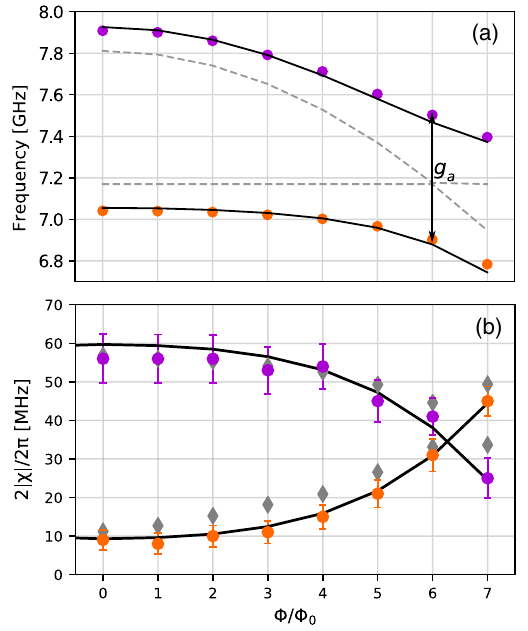
FIG. 9. (a) The lower (orange) and upper (purple) polariton resonant frequencies as function of integer quantum flux. They are fitted (black lines) using the numerical model discussed in Appendix B. The gray dashed lines correspond to the bare cavity and bare ancilla frequencies. An avoided crossing between ancilla and cavity can thus be seen. (b) Cross-Kerr strengths between qubit and lower (orange) and upper (purple) polaritons. Black − g lines are the expected cross-Kerr coupling using χ sin 2 ð θ Þ l ¼ zz − g = ð 2 π Þ ¼ 34 . 5 MHz. The gray cos 2 ð θ Þ with g and χ u ¼ zz zz diamonds are simulated points computed using black box quantization [53] with EM simulation.